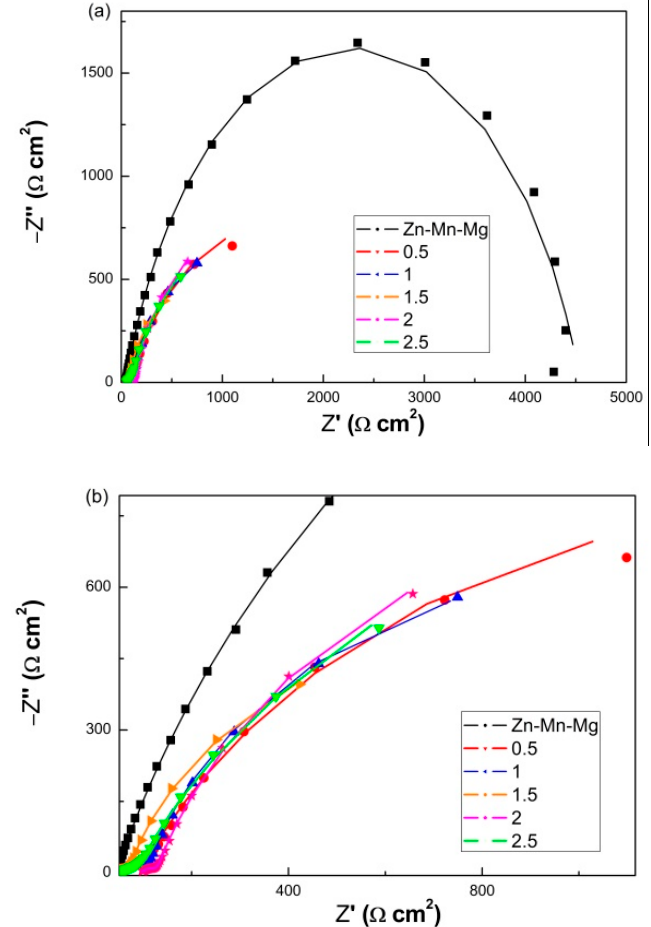
Figure 6. The Nyquist plots of Zn-Mn-Mg alloys and fabricated by the MAO with different NaF concentrations from 0.5 g/L to 2.5 g/L in Hank’s solution at 37 ◦ C: ( a ) Low magnification; ( b ) high magnification.